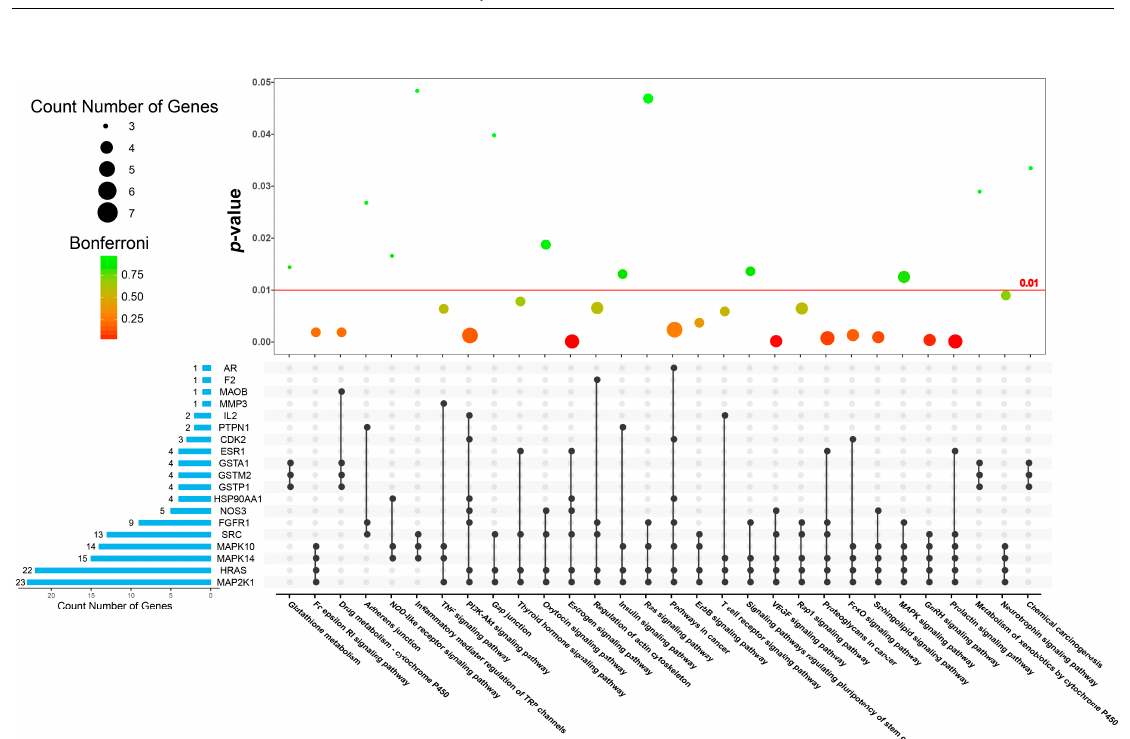
flavonoids, 3 terpene lactones, 3 sterols, 3 fatty acid esters, 1 polyprenol, and 1 lignan associated with